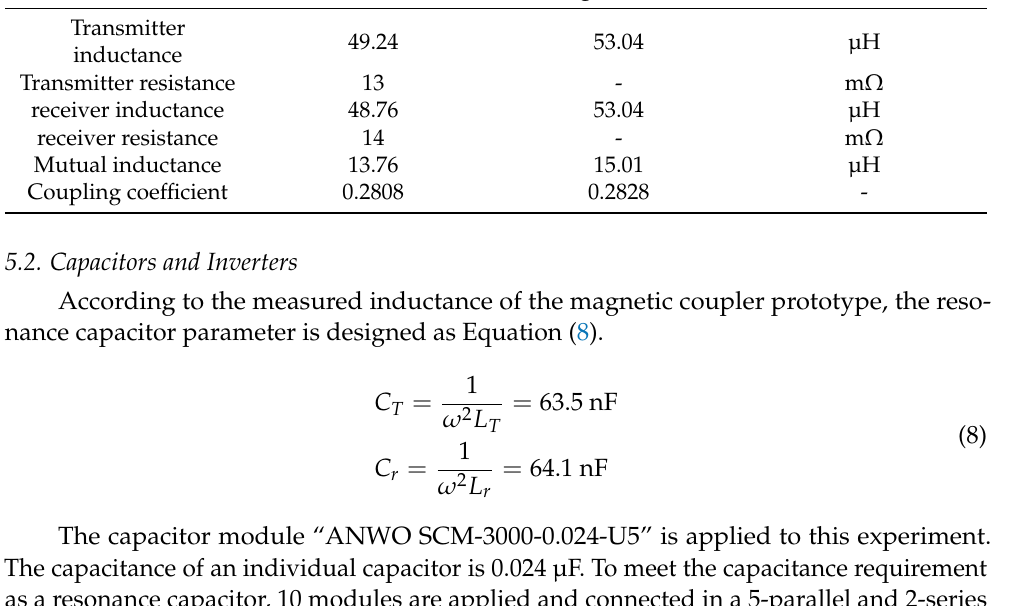
Table 9. Measured values of the magnetic coupler prototype Item Measured Values Designed Values